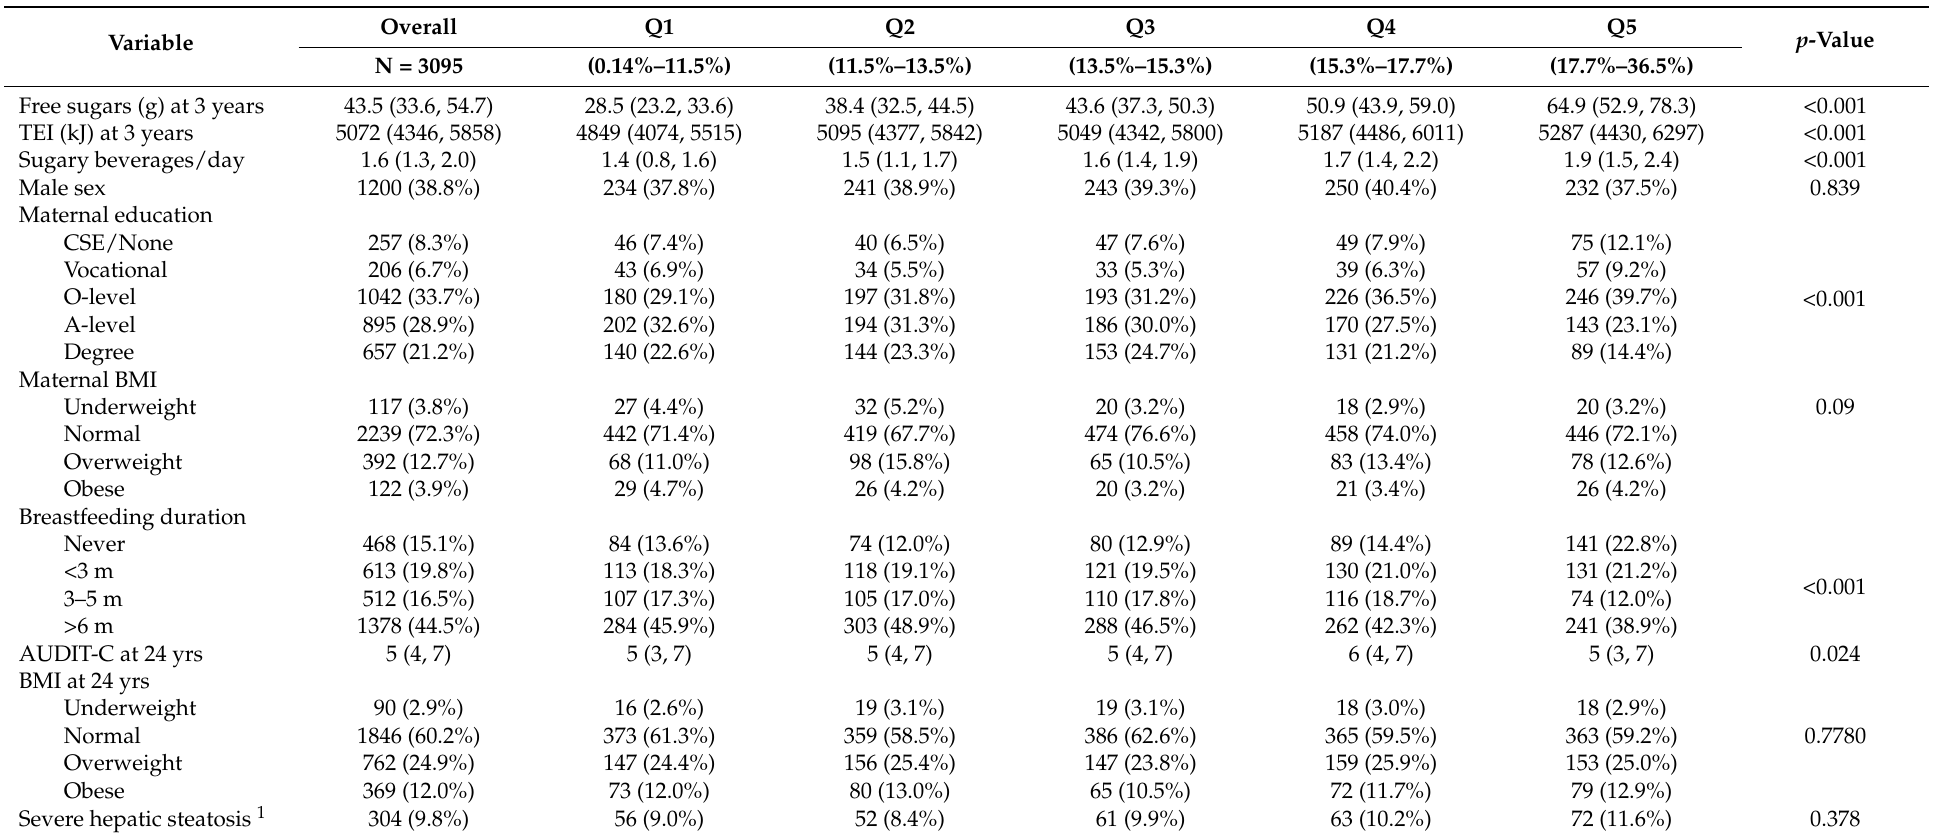
Table 1. Sample characteristics by percent free sugar of total energy intake quintile presented as n (%) or median (IQR) in the ALSPAC